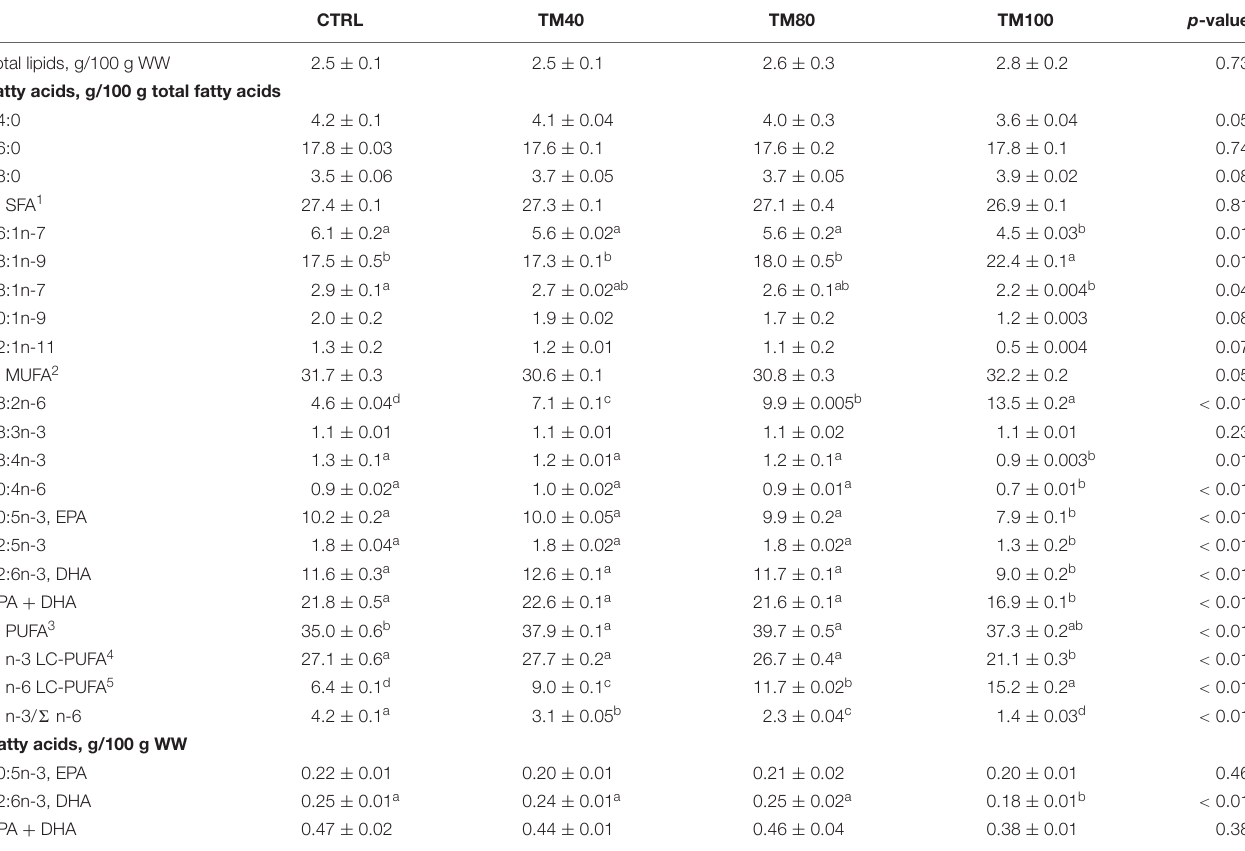
TABLE 6 | Muscle total lipid content and fatty acid composition of the European sea bass fed experimental diets. CTRL TM40 TM80